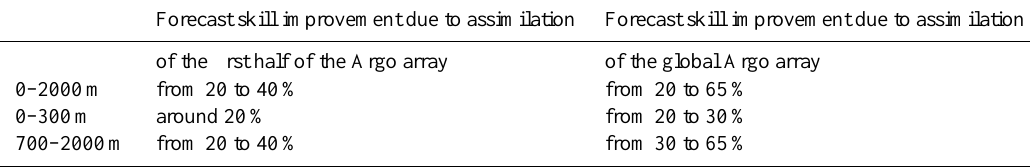
Table 3. Salinity forecast skill improvement derived from the reduction of the RMS salinity innovations. Forecast skill improvement due to